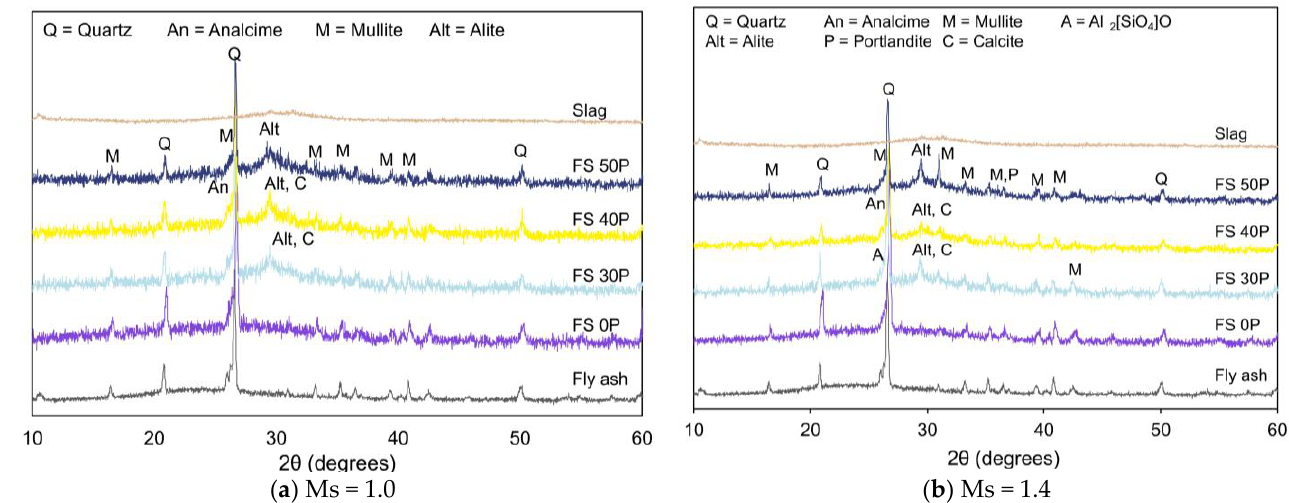
Figure 4. XRD pattern of AAB paste under ambient